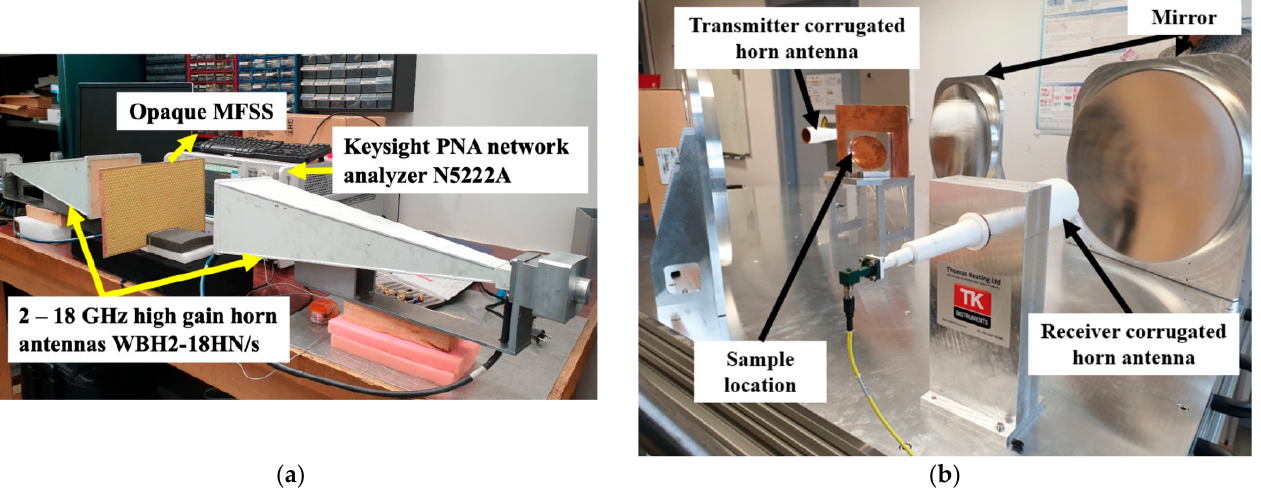
Figure 14. The free space measurement setups for frequency range of ( a ) 2 GHz to 18 GHz, and ( b ) 18 GHz to 40 GHz. 18 GHz to 40